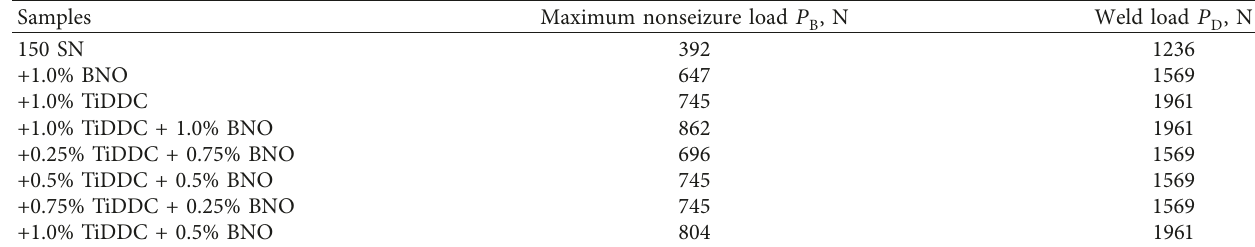
Table 2: Load-carrying properties of TiDDC and BNO.